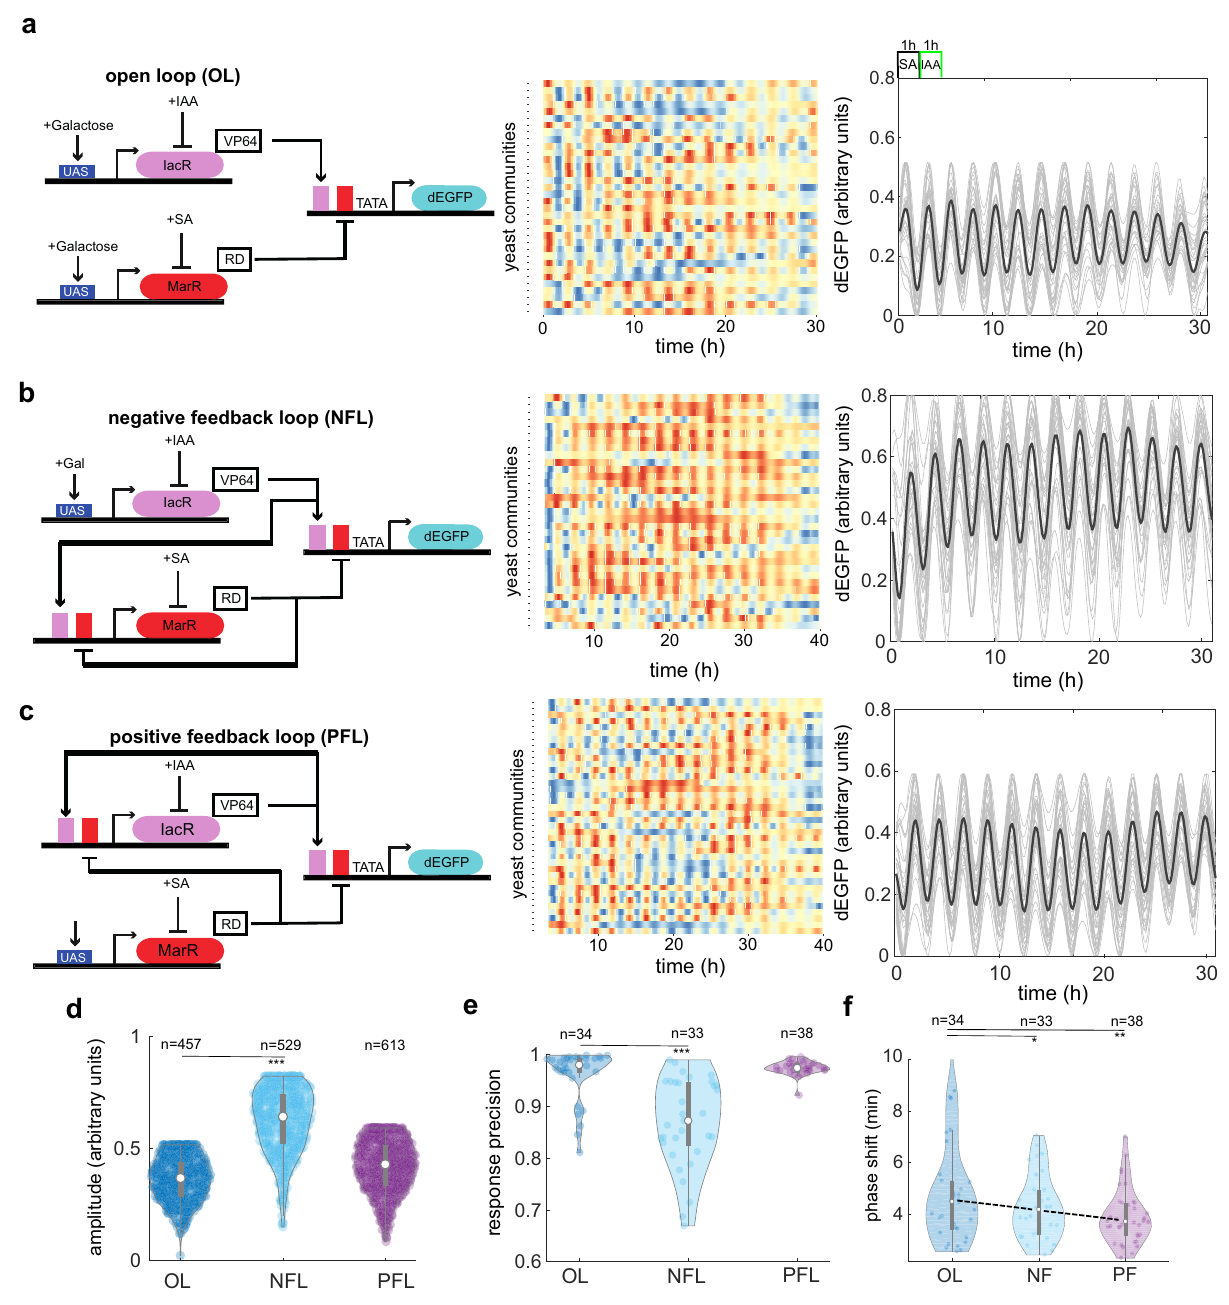
Fig. 4 Closed-loop circuits offer an extended tunability of response in synchronized cell populations. a – c Circuit schematics related to Fig. 1g (left panel), synchronous dynamics across yeast communities visualized with heatmaps of dGFP fl uorescence over time (middle panel), and time-lapse pro fi les with mean trends (right panel black lines) are shown for open-loop system (OL) ( a ) and two closed loop system with either negative feedback (NFL) ( b ) or positive feedback (PFL) ( c ). Color coding scheme is as in Figs. 1 and 3. d Probability distribution of amplitudes for three different circuit variants. Note an ~50% increase of amplitude in NFL systems as compared to the OL system (*** p -value = 1.1 − 10 , a one-way ANOVA with post-hoc Tukey ’ s HSD). e Amplitude increase in the NFL system is counteracted by reduced response precision (*** p -value = 9.4 − 9 , a one-way ANOVA with post-hoc Tukey ’ s HSD). f Inter- community synchrony is further improved by including feedback loops in the original circuit (* p -value = 9.0 − 2 , ** p -value = 9.0 − 3 , a one-way ANOVA with post-hoc Tukey ’ s HSD). The description of violin plots is as in Fig. 1f. A heat map legend is as in Fig. 1i. Source data are provided in the Source Data fi